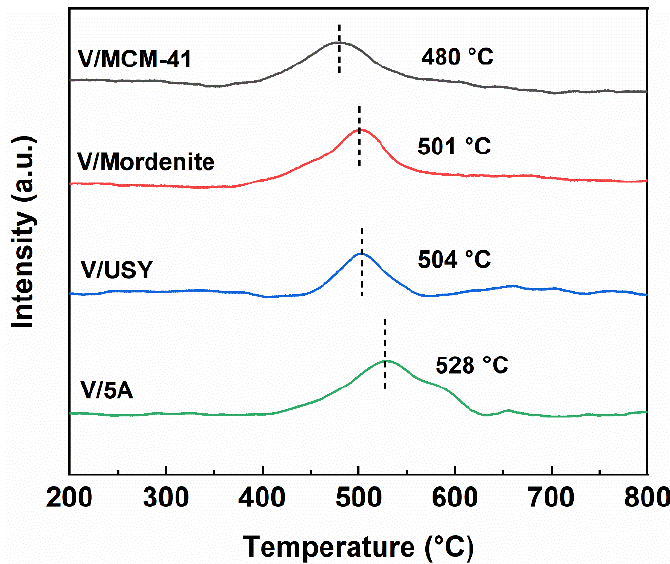
Figure 3. H 2 -TPR profiles of the V/M (M = MCM-41, mordenite, USY and 5A) catalysts.